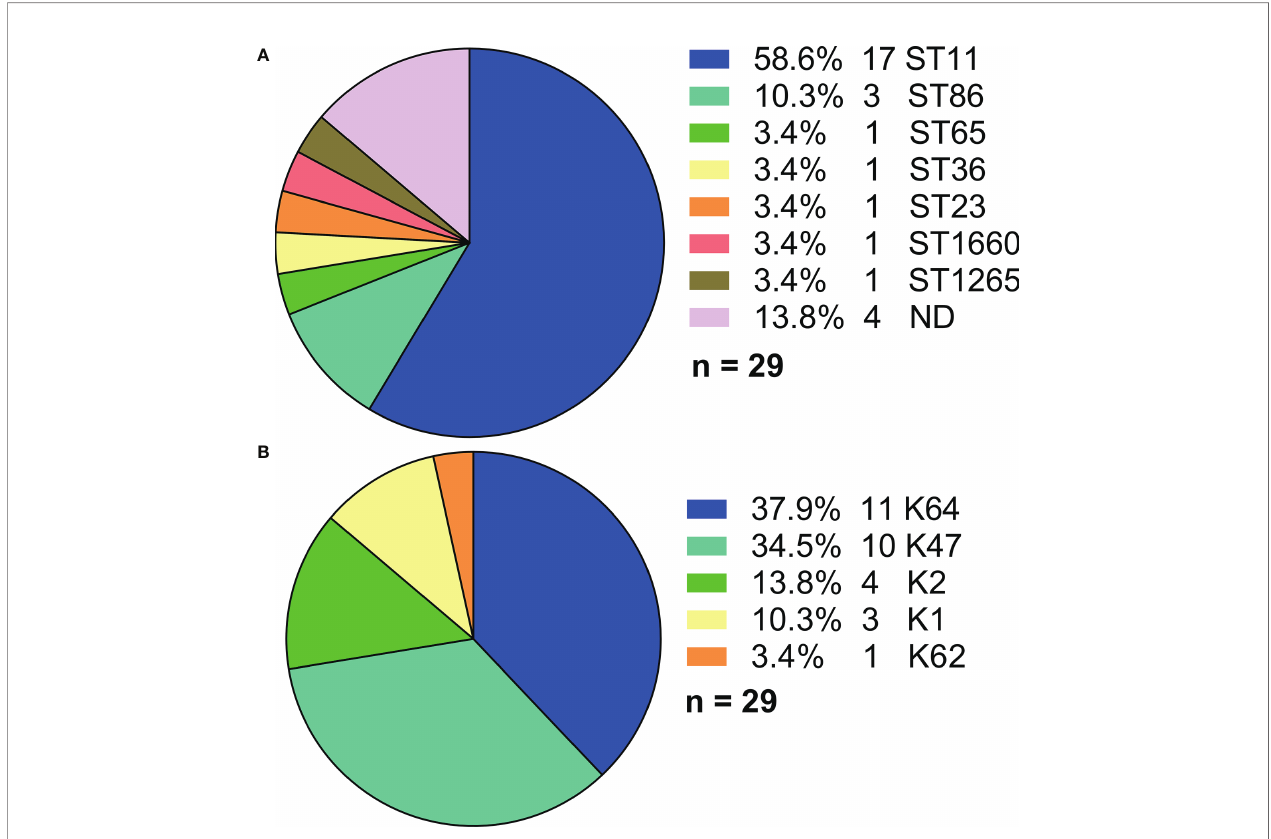
FIGURE 6 | Distributions of STs and serotypes in Hv- bla KPC (+)-KP. (A) Distribution of STs in Hv- bla KPC (+)-KP. (B) Distribution of serotypes in Hv- bla KPC (+)-KP. Statistics were made among the 29 Hv- bla KPC (+)-KP strains. ND, not de fi